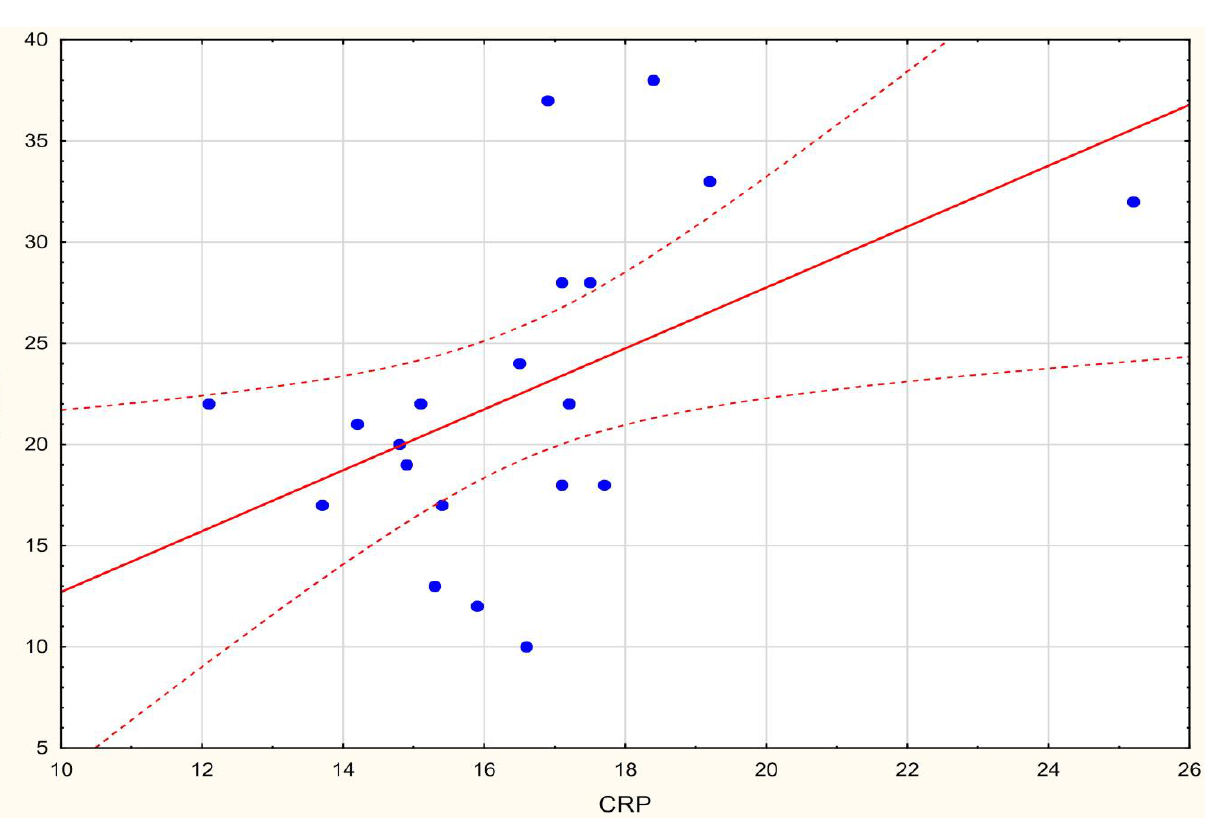
Figure 4. The correlation between C-reactive protein levels and positive-symptom scores. Analysis showed that MDA level was positively correlated with positive-symptom stores (r Spearman = 0.439, p < 0.05). The results of the analysis are presented in Figure 5. No correlation between the oxidative stress variables and CRP was found in the present research. The results are presented in Table